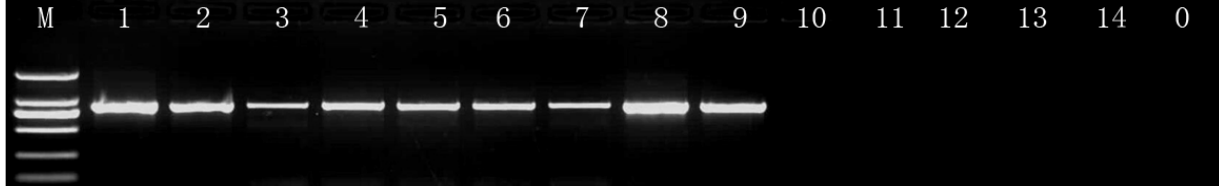
Fig. 4. The specificity of the n-PCR for identifying the S. nitidum ; M, DL2000 (TAKARA); 1~9, Snit1~Snit9; 10, Shal1; 11, Salm1; 12, Sbic1; 13, Spro1; 14, Ssud1, 0,